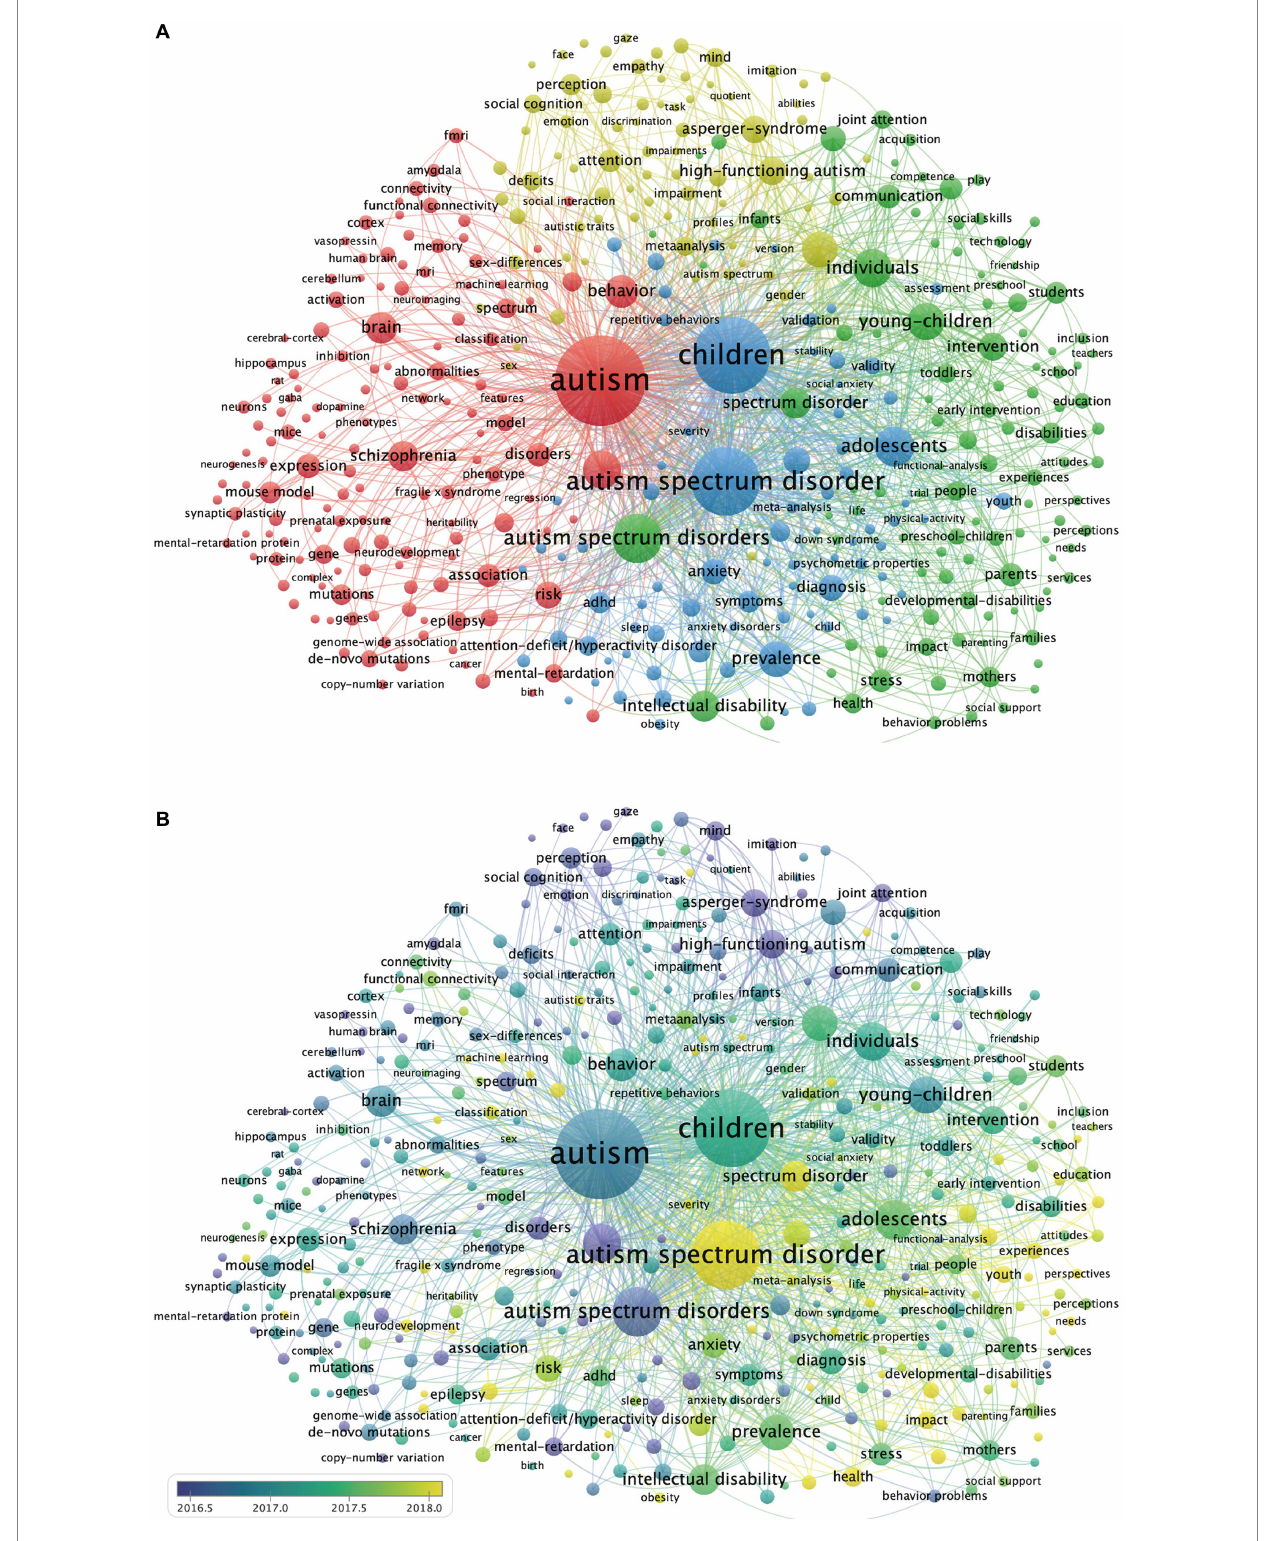
FIGURE 6 Keywords co-occurrence network. (A) Cluster analysis of keywords. There are four clusters of keywords: red indicates Cluster 1 ( n = 145), green indicates Cluster 2 ( n = 104), blue indicates Cluster 3 ( n = 78), yellow indicates Cluster 4 ( n = 80). (B) Evolution of keyword frequency. A minimum number of occurrences of a keyword = 200. Overall, 407 keywords met the threshold criteria. The yellow keywords appear later than purple